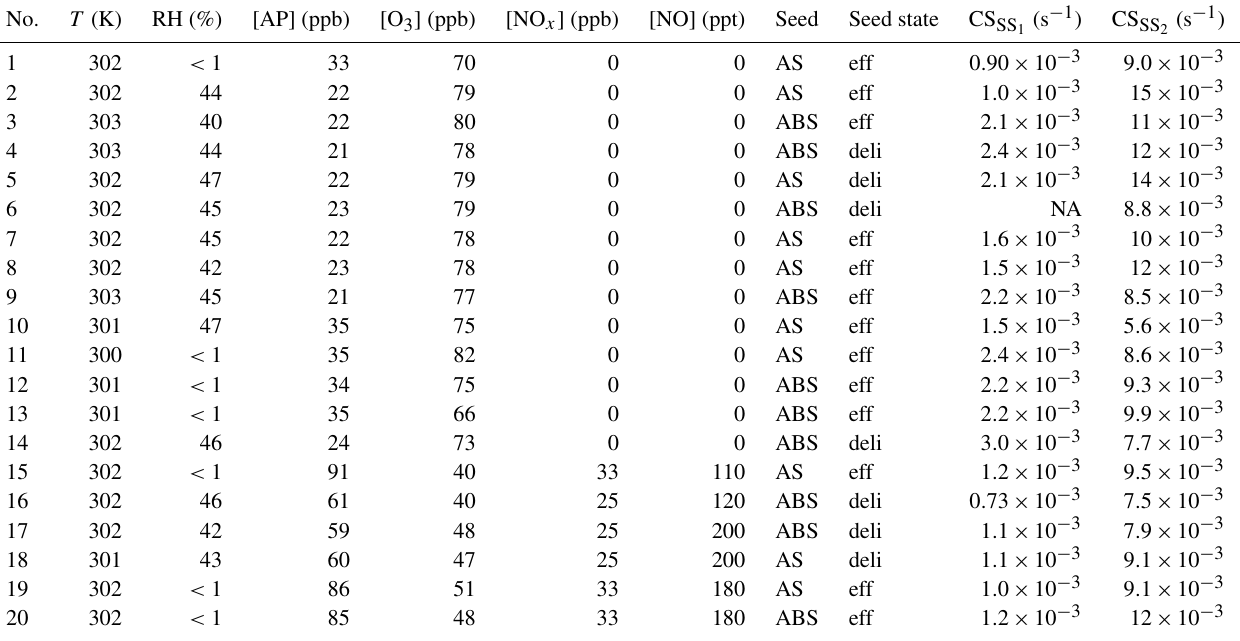
Table A1. Overview of experimental conditions. AS: ammonium sulfate; ABS: ammonium bisulfate; eff: effloresced seed; and deli: del- iquesced seed. Condensation sinks are calculated for C 10 H 16 O 7 from the dry size distribution, and listed separately for the steady states before (SS 1 ) and during (SS 2 ) seed injection. For the beginning of experiment 6, the DMPS was malfunctioning and CS is thus not